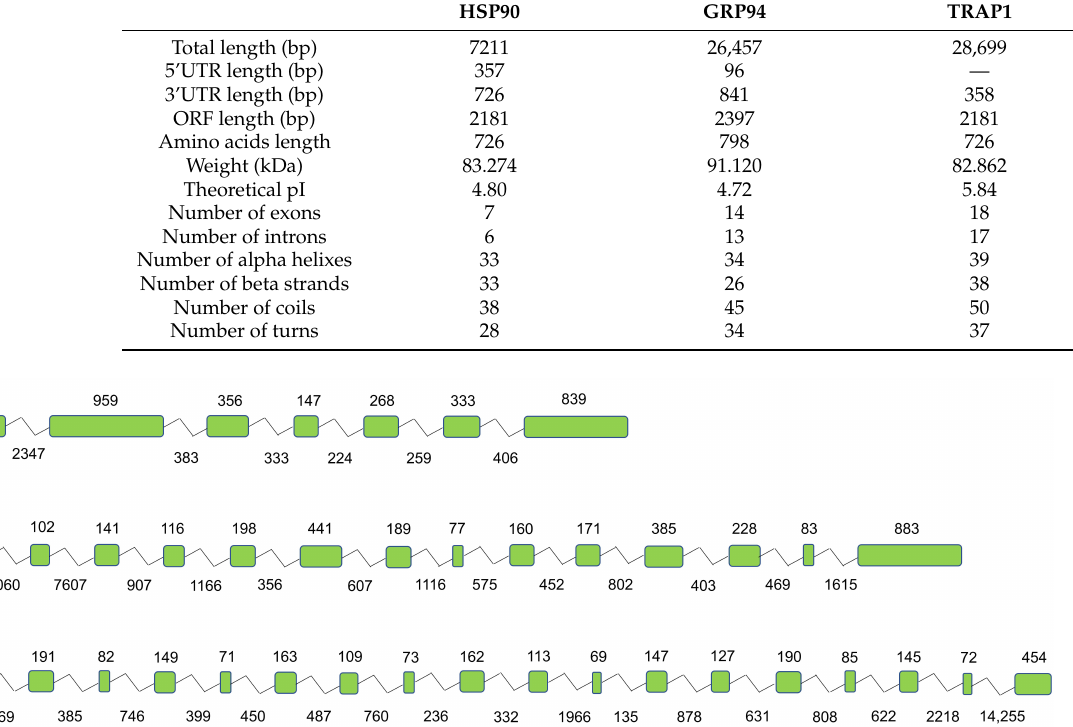
Figure 1. Gene structures for CfHSP90s . Green boxes indicate the exons, and the polylines indicate the introns. The numbers on the boxes indicate the lengths of the exons, the numbers under the lines indicate the lengths of